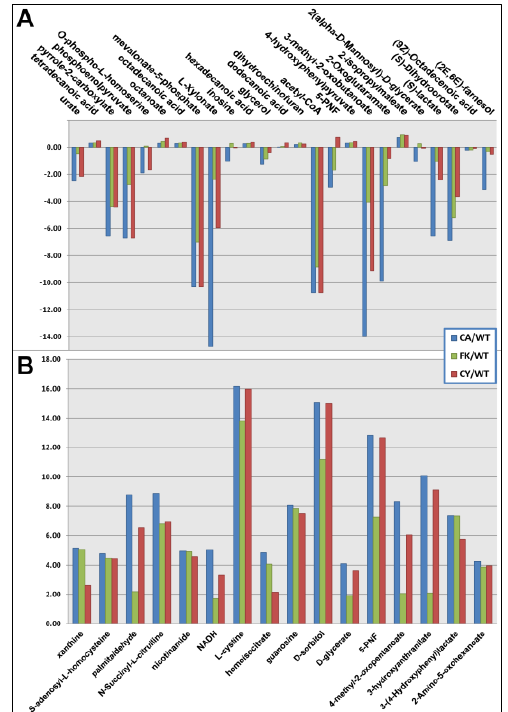
Figure 2. Annotated features from targeted mining results detected at highest and lowest levels in wild-type and calcium treated datasets. ( A ) Twenty-five annotated features detected at the highest level in wild-type and the lowest level in calcium treated